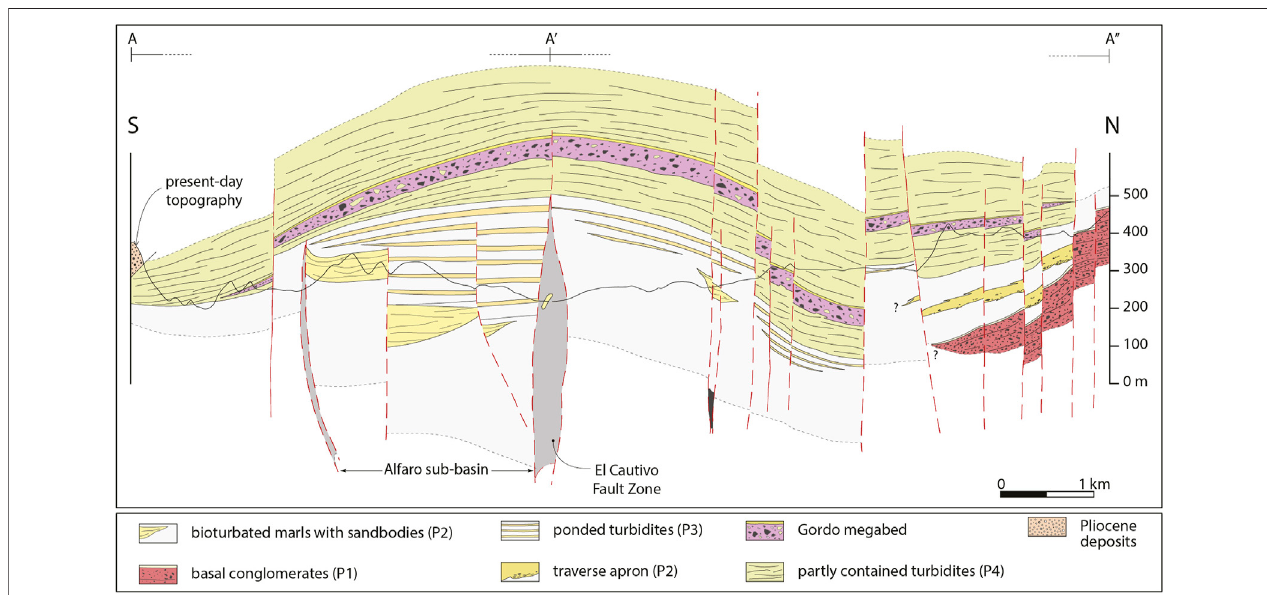
FIGURE 3 | N-S cross-section (vertical exaggeration of x4; see Figure 2 for location) showing the stacked turbidite deposits of the central Tabernas Basin (identi fi edbyphase – seetextfordiscussion)andthemainfaults.NotetheGordomegabed – animportantmarkerhorizon,andthepresenceofsomefaultsthatonlyaffect the lower stratigraphic units. The position of the Alfaro-sub-basin is also indicated. Modi fi ed from Haughton (2000).